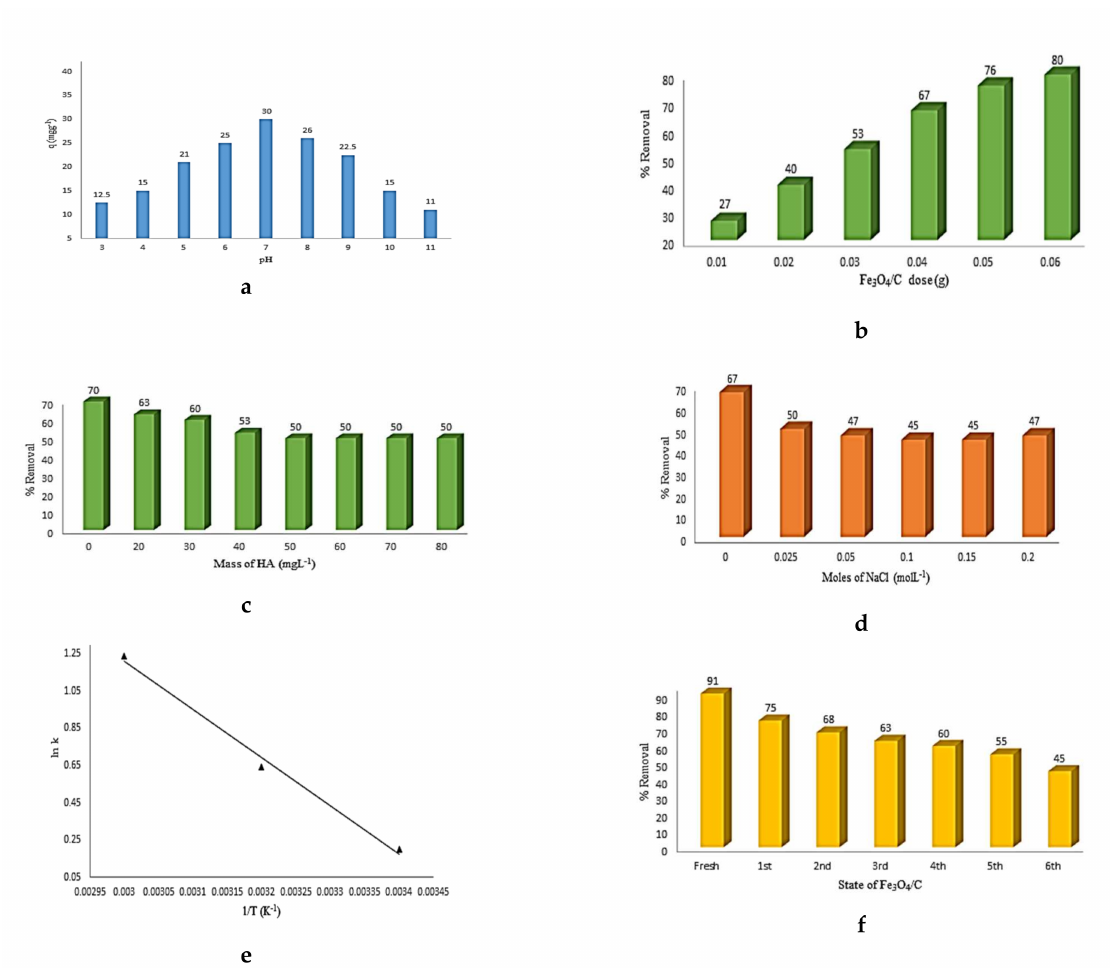
Figure 5. ( a ) Effect of pH on adsorption ( b ) Effect of adsorbent dosage. ( c ) Effect of Humic acid ( d ) effect of ionic strength ( e ) Van’t Hoff plot effect of ionic strength. ( f ) Regeneration of the mango Fe 3 O 4